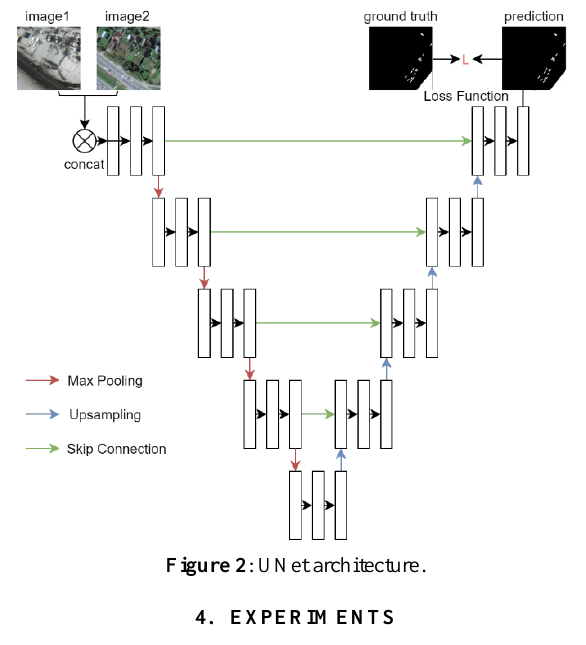
Figure 2 : UNet architecture.